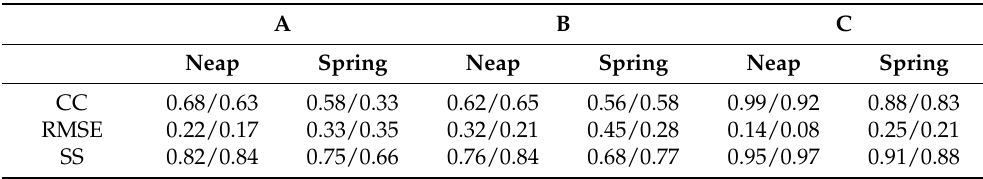
Table 2. CCs, RMSEs and SSs of the current velocities at the measurement sites (value in the surface layer/value in the bottom